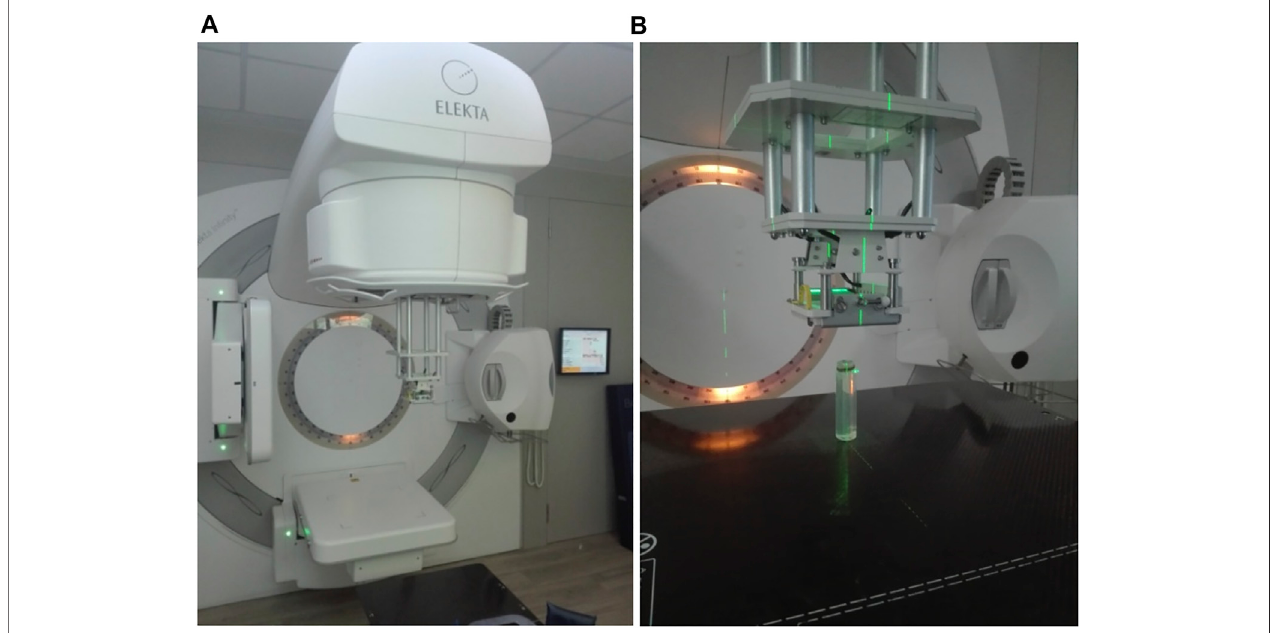
FIGURE 5 | (A) The 2 element, 2 channel, small loop linear polarised cylindrical coils used for signal detection. The irradiated vial is positioned on a thick plexiglass surface and tightenedwithappropriate straps priortoscanning. Paramagneticphantomsolutions(two bottles of500 ml)are placedinthevicinityofthereceivercoils for appropriate RF body coil transmitter ohmic loading. (B) A close-up.